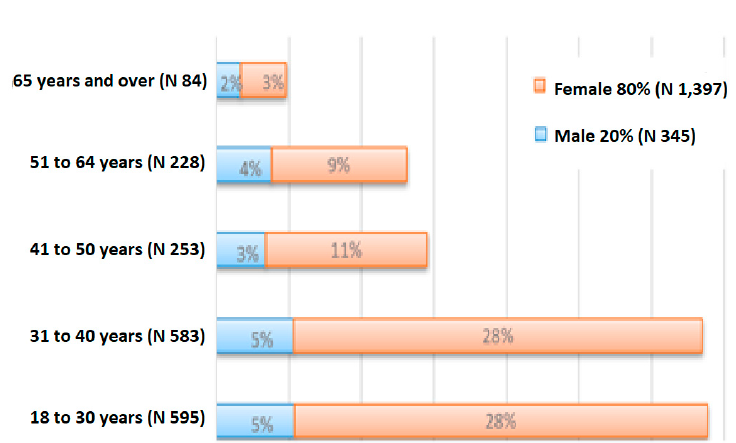
Figure 1. Overall sample of the citizens’ survey (percentage and number, divided into ages between 18 and 65 years as well as gender). (Source: Authors, 2020).